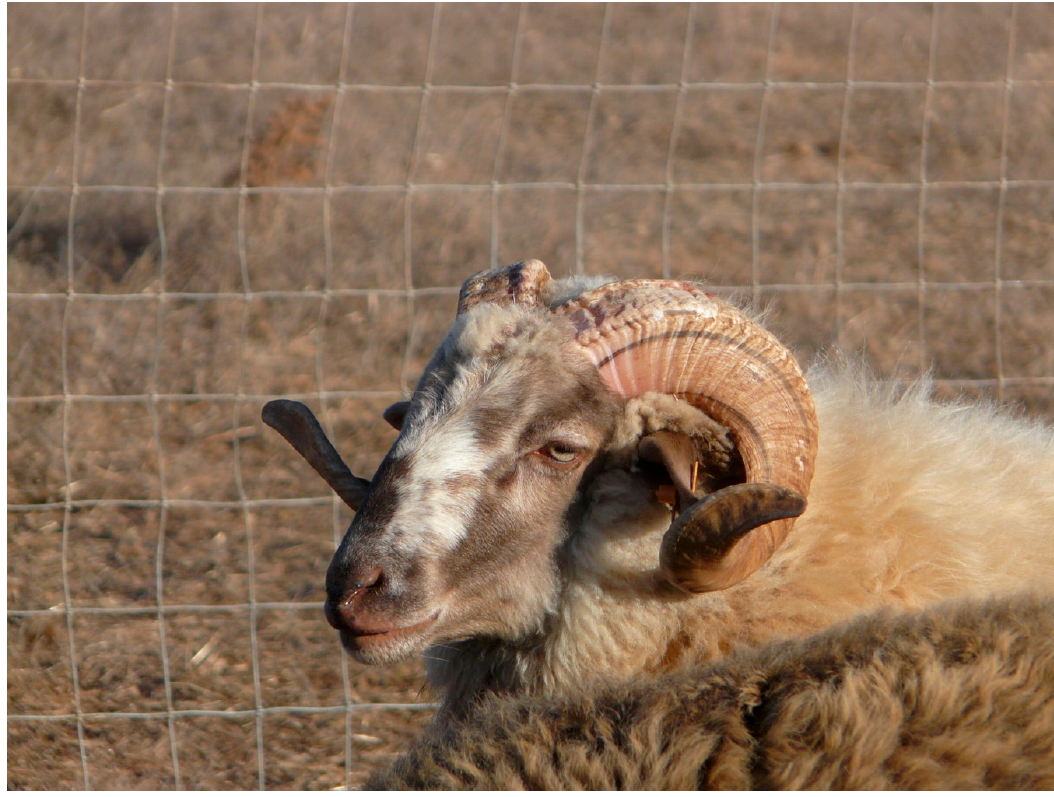
Figure 3. Navajo-Churro ram. Photo by D.P. Sponenberg.